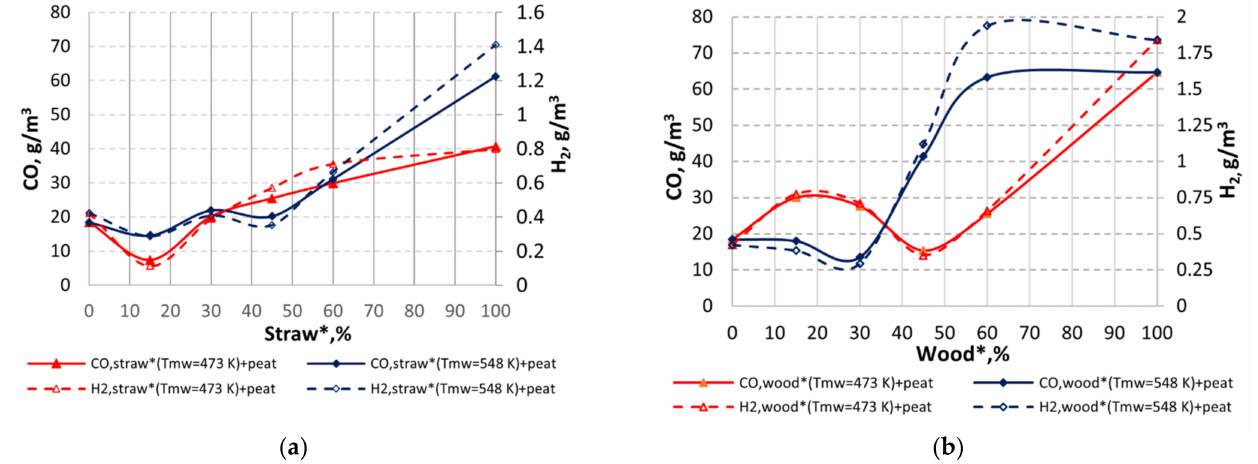
Figure 2. Effect of changes (variations) in composition and pre-treatment temperature of selectively pre-treated wheat straw* ( a ) and wood* ( b ) blends with raw peat pellets on the yield of combustible volatiles at the gasifier